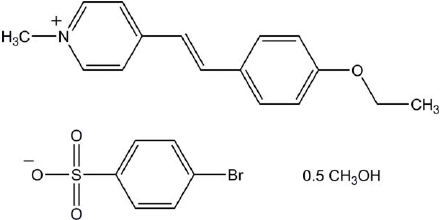
Data collection Bruker APEXII CCD area-detector diffractometer Absorption correction: multi-scan ( SADABS ; Bruker, 2005) T min = 0.383, T max = 0.721